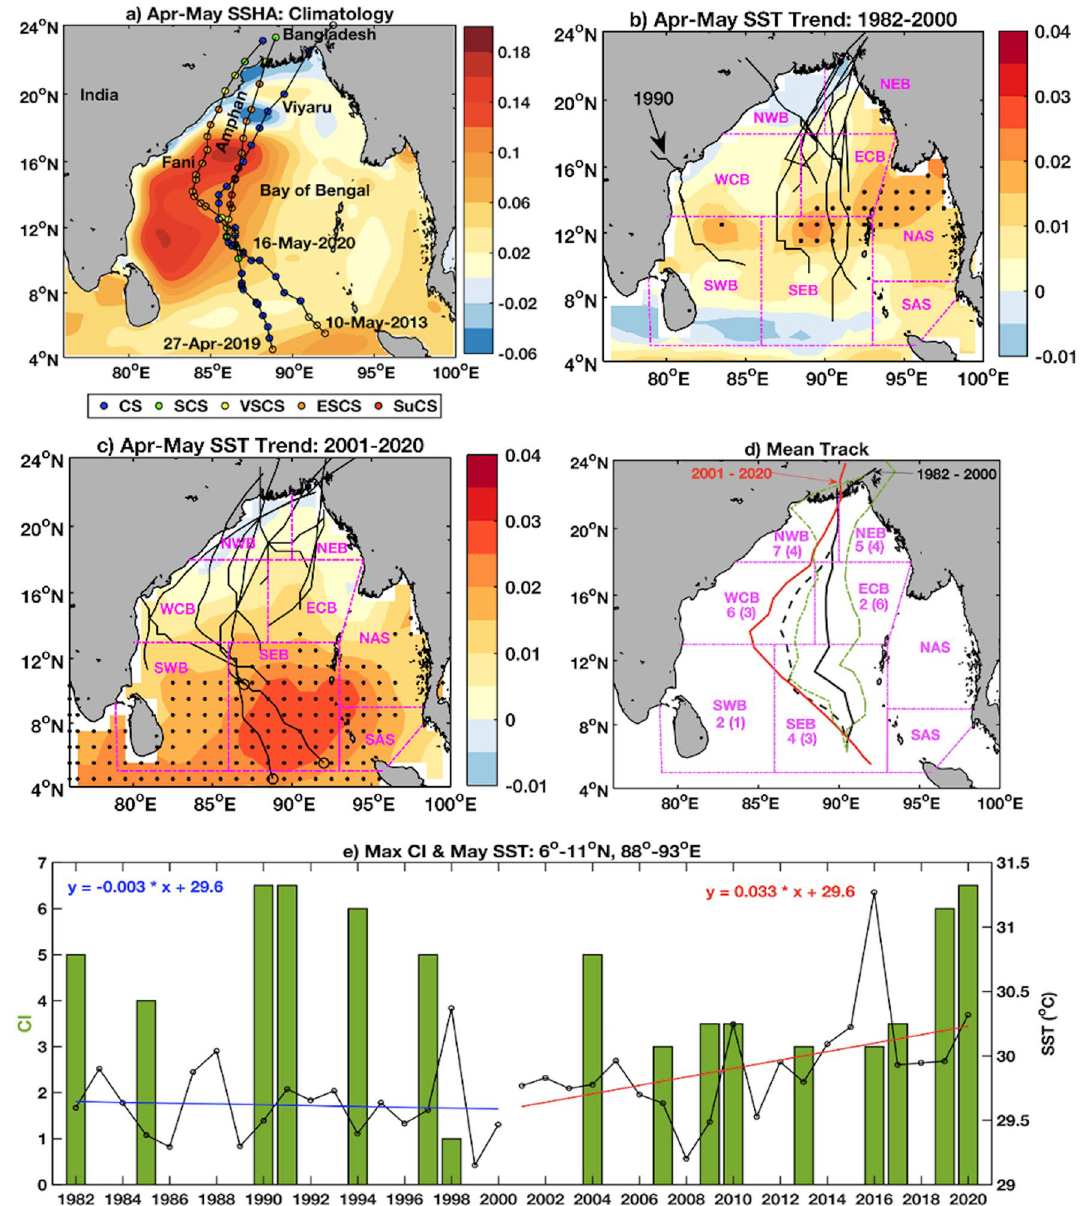
Figure 1. ( a ) Best-estimate tracks for cyclones Viyaru (10th–16th May 2013), Fani (27th April–3rd May 2019), and Amphan (16th–21st May 2020). Different stages of development for each cyclone are shown along each track with color filled circles, which are explained in the legend below the panel. Climatological SSHA for April– May in the background shows the typical coverage of the WBC and its warm eddies during spring. ( b ) The SST ◦ C / year trend ( ) during April–May and cyclone tracks during 1982–2000 are shown. ( c ) Similar to ( b ), but for 2001–2020. The magenta boundaries show the regions of the Bay of Bengal as per IMD (see “Methods” section). ⋅ The shaded ‘ ’ regions in ( b,c ) show 90% significance of the SST trend in their respective periods indicating the southwestward shift of the same in recent decades. ( d ) Mean tracks of the pre-monsoon cyclones (except the ◦ N 1990 cyclone with land fall around 16 ) during 1982–2000 (solid black) and during 2001–2020 (red line). The dashed black line denotes the mean track including the 1990 cyclone. The dotted green lines are the one standard deviation of cyclones (except 1990). Westward shifting of the Pre-monsoon cyclone tracks is evident. The numbered pairs ‘m (n)’ indicate the number of cyclones passing through each IMD region during ‘2001– 2020 (1982–2000)’. ( e ) Maximum current intensity (CI) (bar diagram) and SST yearly trend during 1982–2000 ◦ E ◦ N (blue line) and 2001–2020 (red line) in the southern Bay of Bengal (6–11 , 88–93 ). The maps (coastlines) are created with Matlab M_Map v1.4 toolbox (https:// www. eoas. ubc. ca/ ~rich/ map.